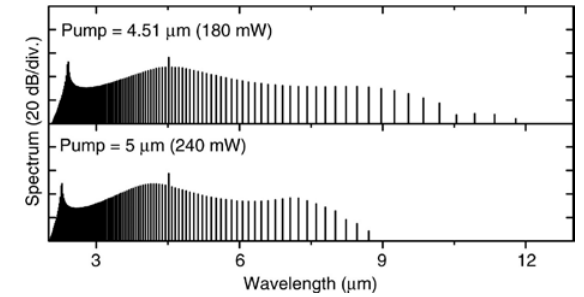
Figure 6: Pump wavelength is shifted from 4.51 to 5 μ m,